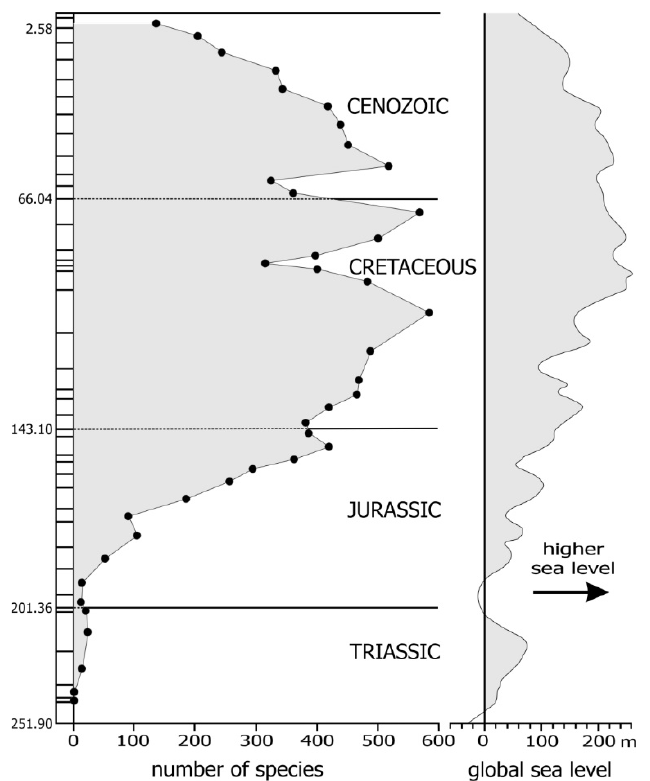
Figure 15. Left. The diversity of fossil dinoflagellate species after MacRae et al. [67] plotted against geological time in millions of years: Right Long-term (second order) sea-level curve, modified after the “Mesozoic-Cenozoic Cycle Chart” of Haq et al. [75]. Please note that this curve is based on the timescale from Haq et al. [75], which differs slightly from timescales currently in use: however, the small difference does not hinder a broad comparison between plots. The zero in the horizontal axis is a baseline and refers to contemporary sea level. For further explanation, see [67].